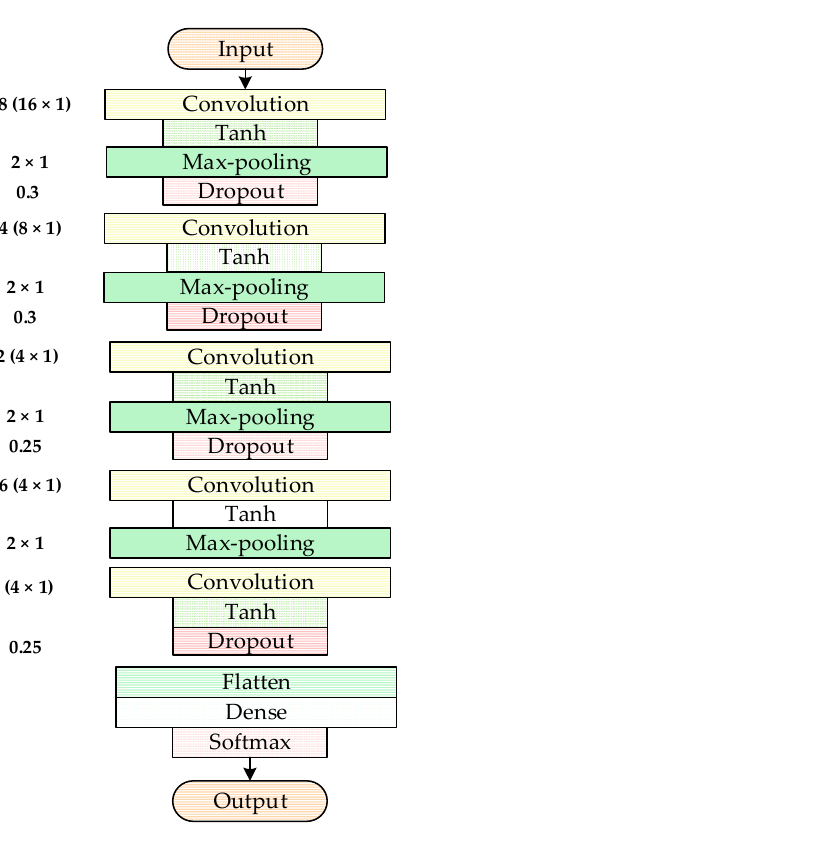
Figure 4. One-dimensional convolution neural network (1D-CNN) network structure for bearing fault diagnosis. Table 2. 1D-CNN network model parameter setting.